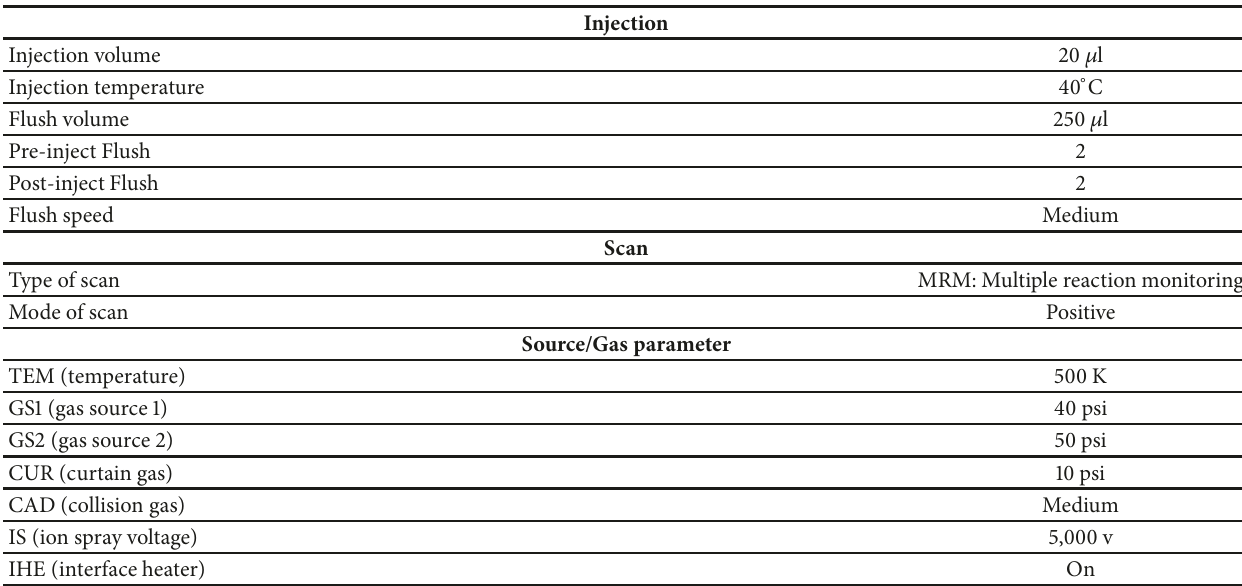
Table 1: Optimal instrumental